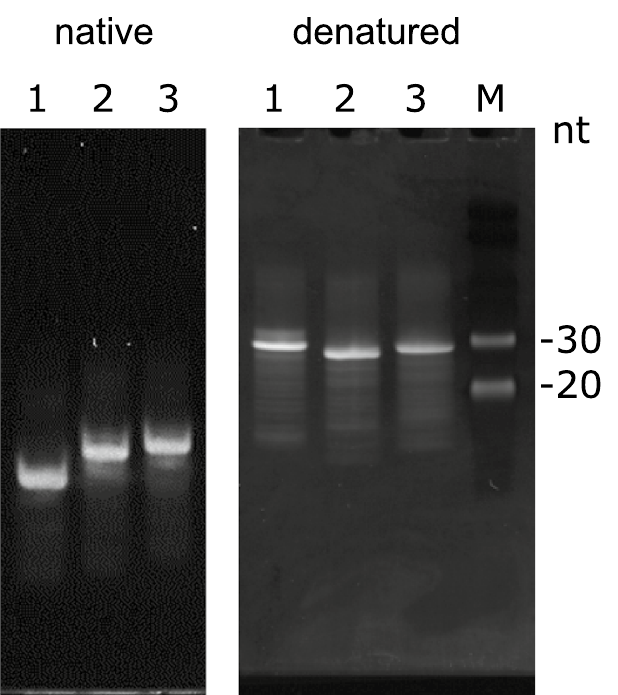
Figure 2. Characteristics of model RNAs analysed by PAGE. Twelve percent native (left) and denatured (right) PAGE are shown with TP-G1G-36, TP-G2G-37, and TP-G3G-38 for lanes 1, 2, and 3, respectively. Line M represents the size marker for single stranded